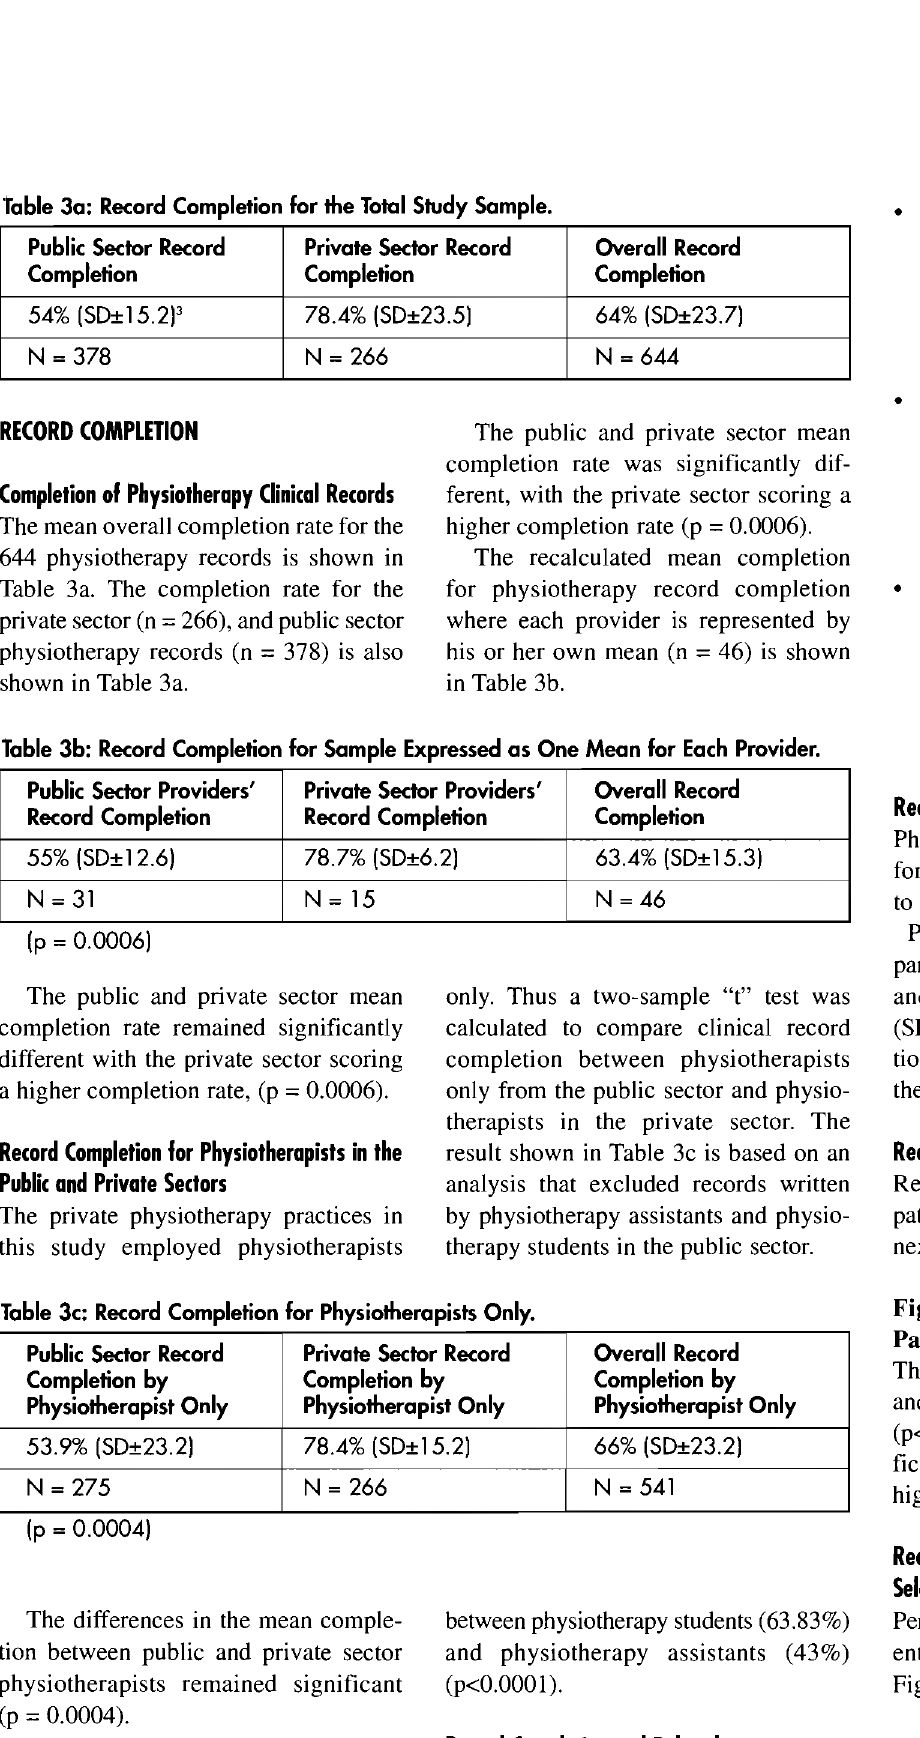
Figure 3: Record Completion for Different Patient Conditions